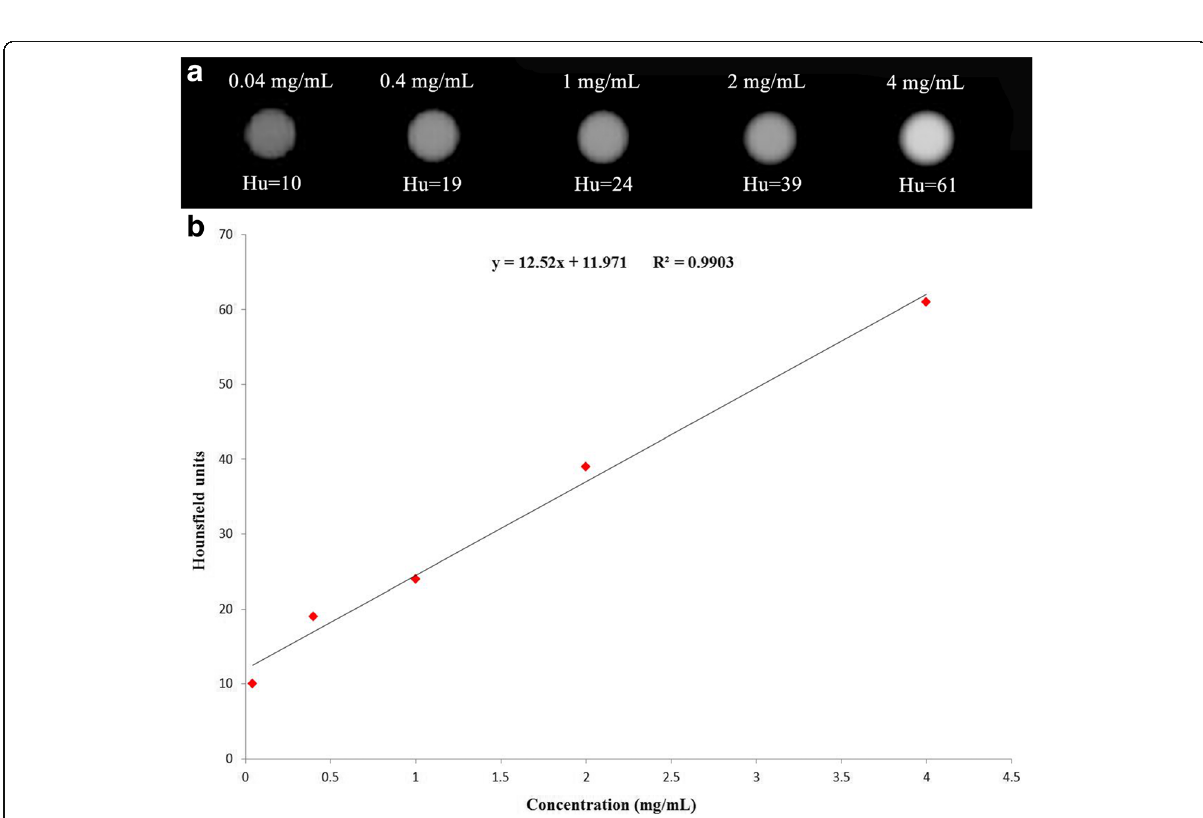
Fig. 4 Hounsfield units of GNR-SiO 2 -Ab. a In vitro CT images of GNR-SiO 2 -Ab suspended in PBS. The concentration (mg/mL) in each sample is provided at the top of the respective image. b CT attenuation plot of GNR-SiO 2 -Ab at various concentrations in the range from 0.04 to 4